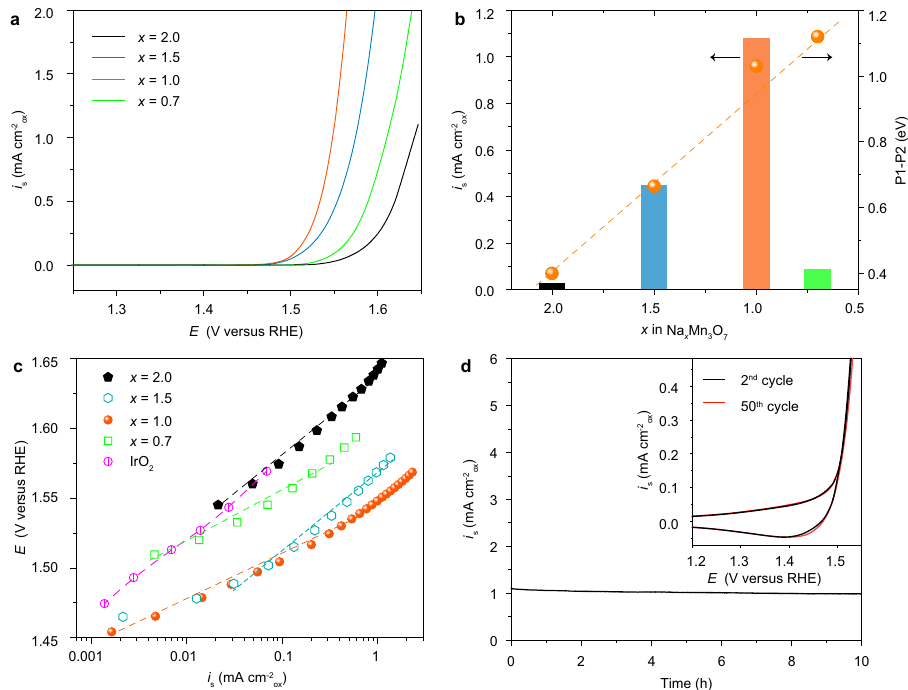
Fig. 4 Electrocatalytic OER measurements. a Polarization curves (current normalized by oxide BET surface area) of the as-synthesized Na x Mn 3 O 7 . (The 2st LSV curve is used for comparison.) b Comparison of the normalized current densities based on BET surface area at 1.55 V versus RHE (the right y axle shows the relationship between P1 and P2 with the number of Na + in Na x Mn 3 O 7 .). c Tafel plots with the previously benchmarked IrO 2 35 as a comparison. d Chronoamperometric curve of NaMn 3 O 7 at 1.55 V versus RHE (The inset shows the 2nd, 10th, 25th, and 50th CV scans of NaMn 3 O 7